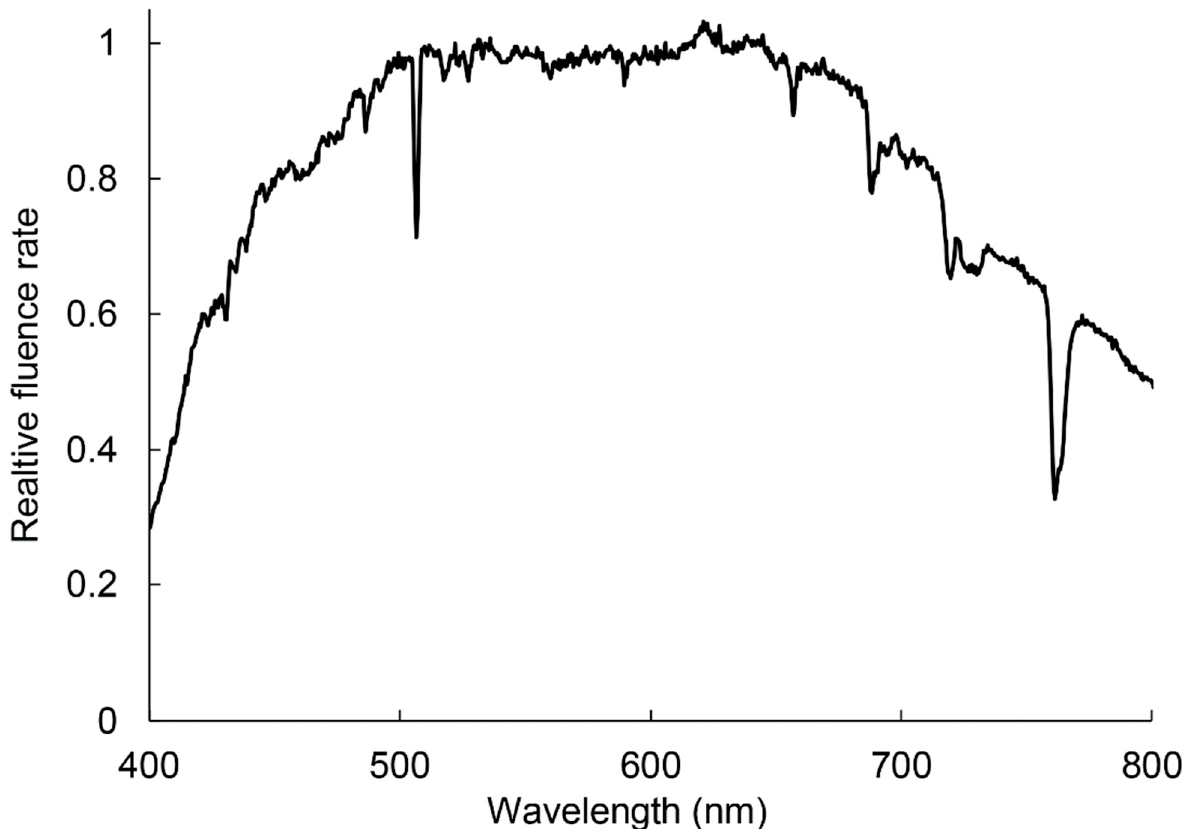
Figure 11. Normalized relative light spectrum distribution in shaded vs. open locations. The irradiance spectra were estimated by measurement of sunlight reflected from white etalon placed at the level of leaves.